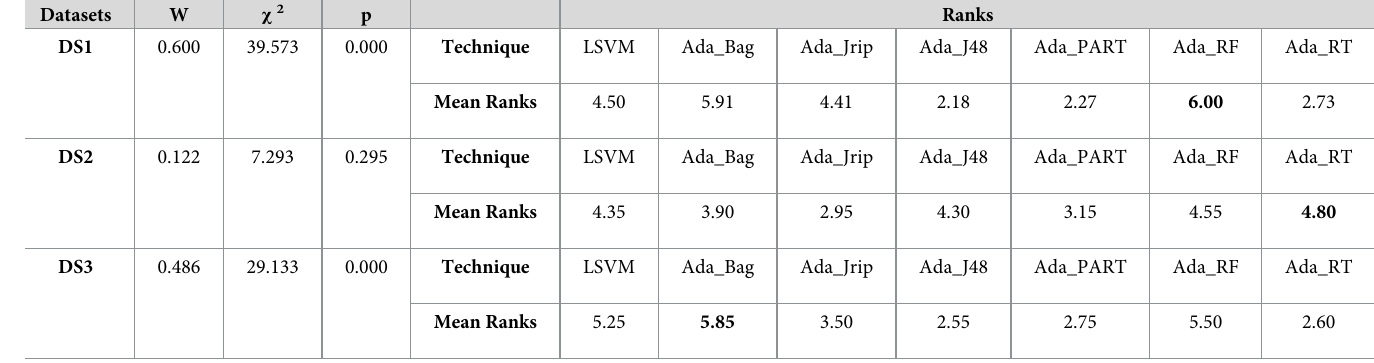
Table 15. Rankings of existing best performing classifier (LSVM) and AdaBoost ensemble classifiers, based on Kendall’s W test results using the MDDR dataset by AUC measure.